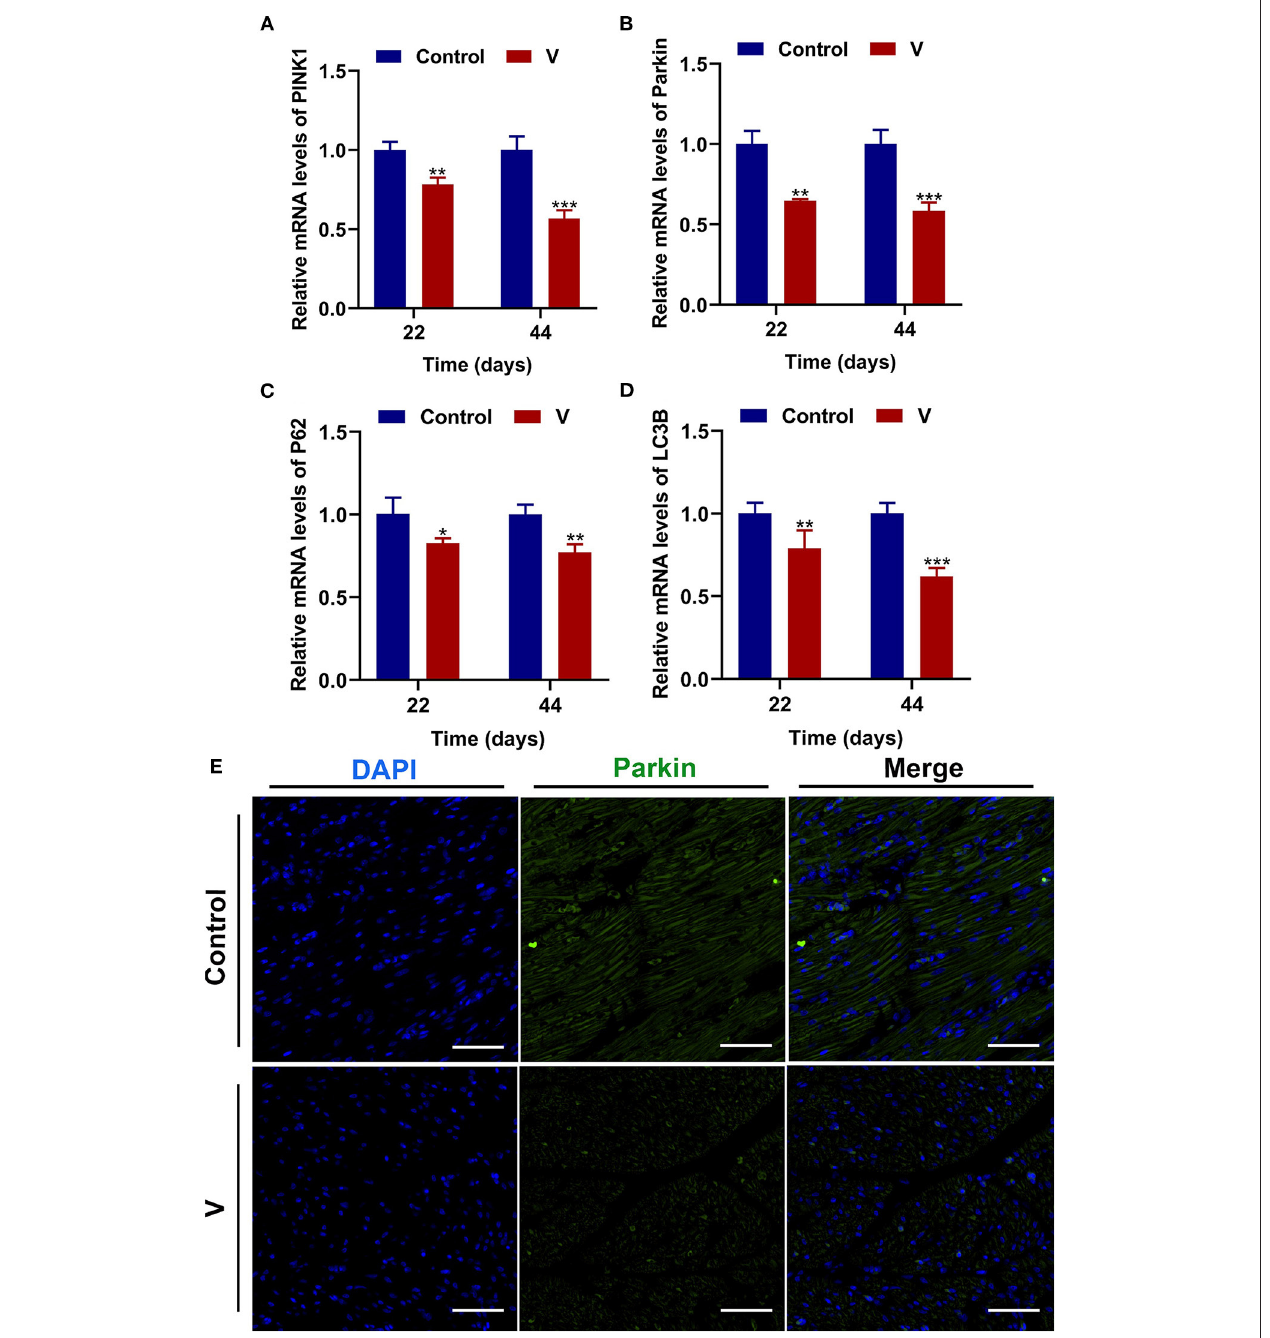
FIGURE 5 | V exposure caused the inhibition of mitophagy in the heart of ducks. (A–D) PINK1, Parkin, P62, and LC3B mRNA levels. (E) Fluorescence microscope analysis of mitophagy. In this image, the nucleus straining is shown in blue, Parkin straining is shown in green, the bright green light is the fluorescent spot ( × 400 total magnification). The scale bar is 20 µ m. * p < 0.05, ** p < 0.01, and *** p <